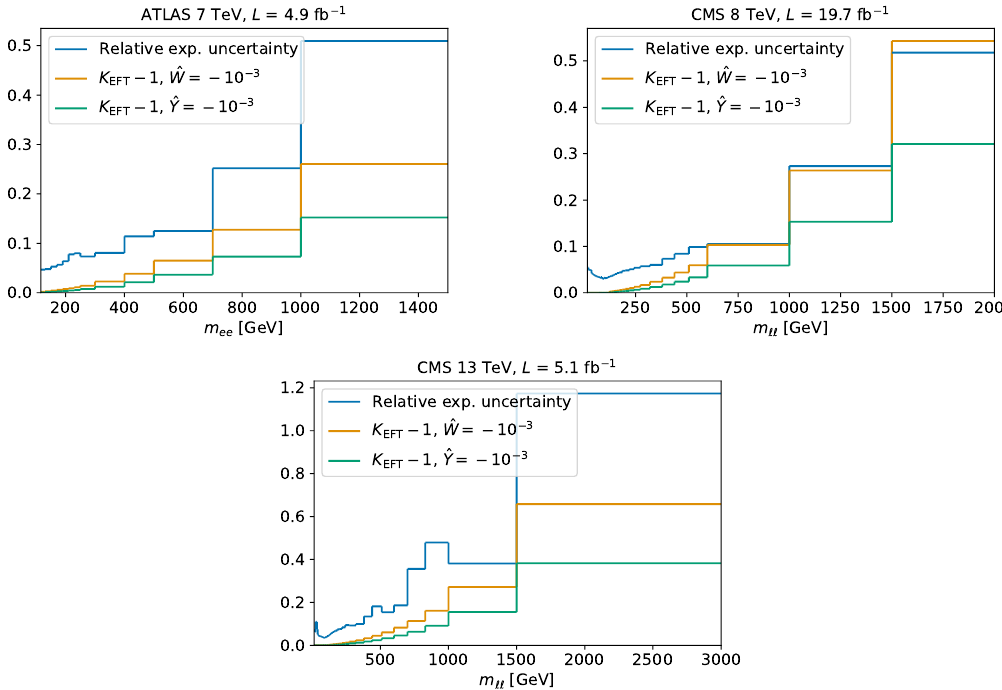
Figure 2 . Comparison between the (relative) experimental uncertainties and the corresponding EFT corrections, K EFT ( ˆ W, ˆ Y ) − 1 in eq. (3.9), for the ATLAS 7 TeV, CMS 8 TeV, and CMS 13 TeV Drell-Yan m ‘‘ distributions, for two representative values of ˆ W and ˆ Y